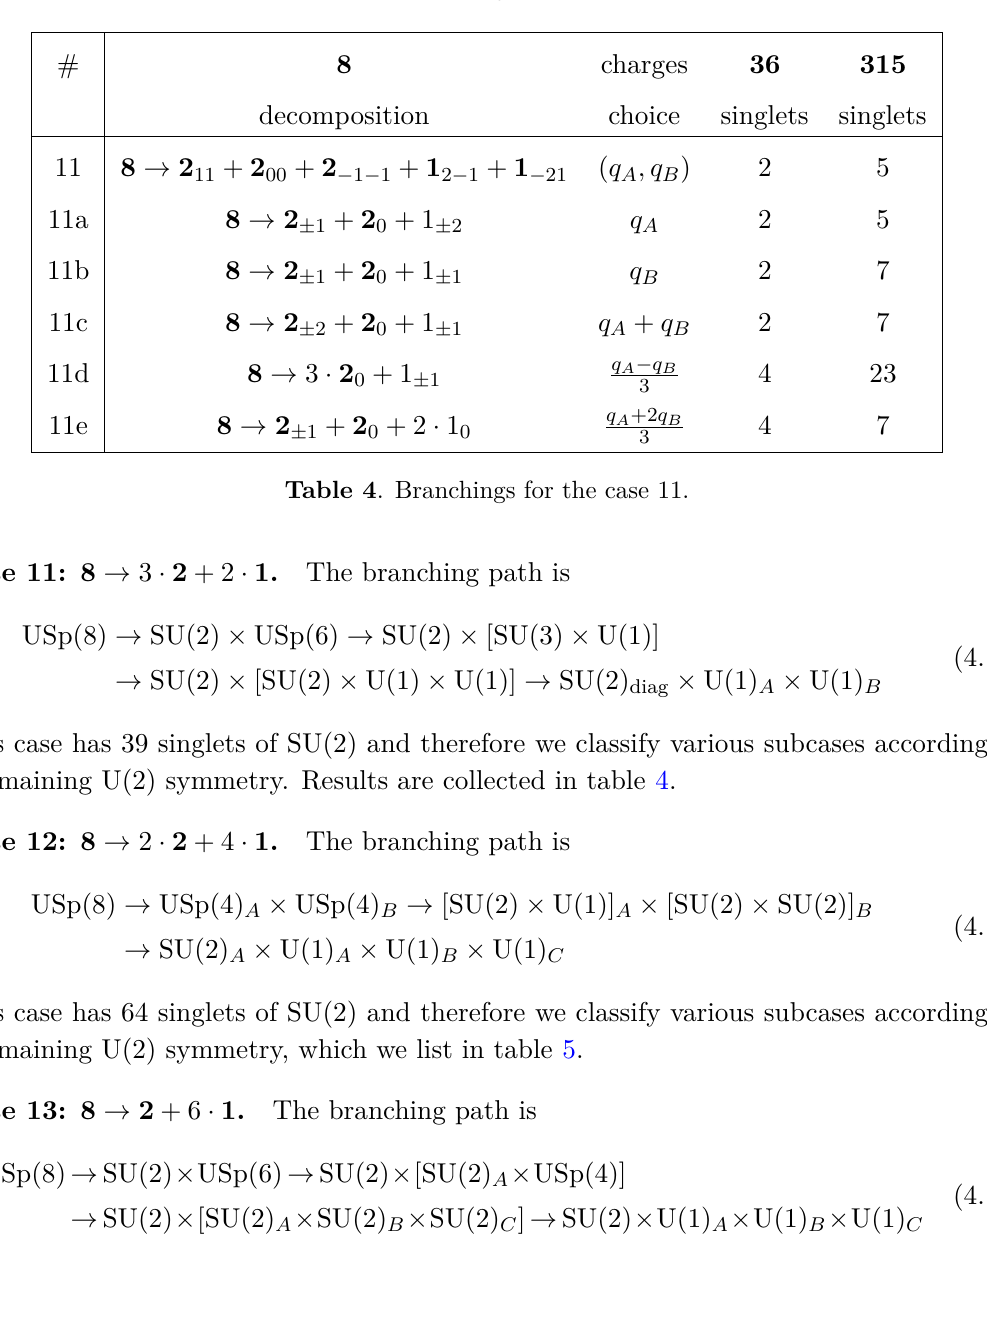
Table 3 . Branchings for the case 10.